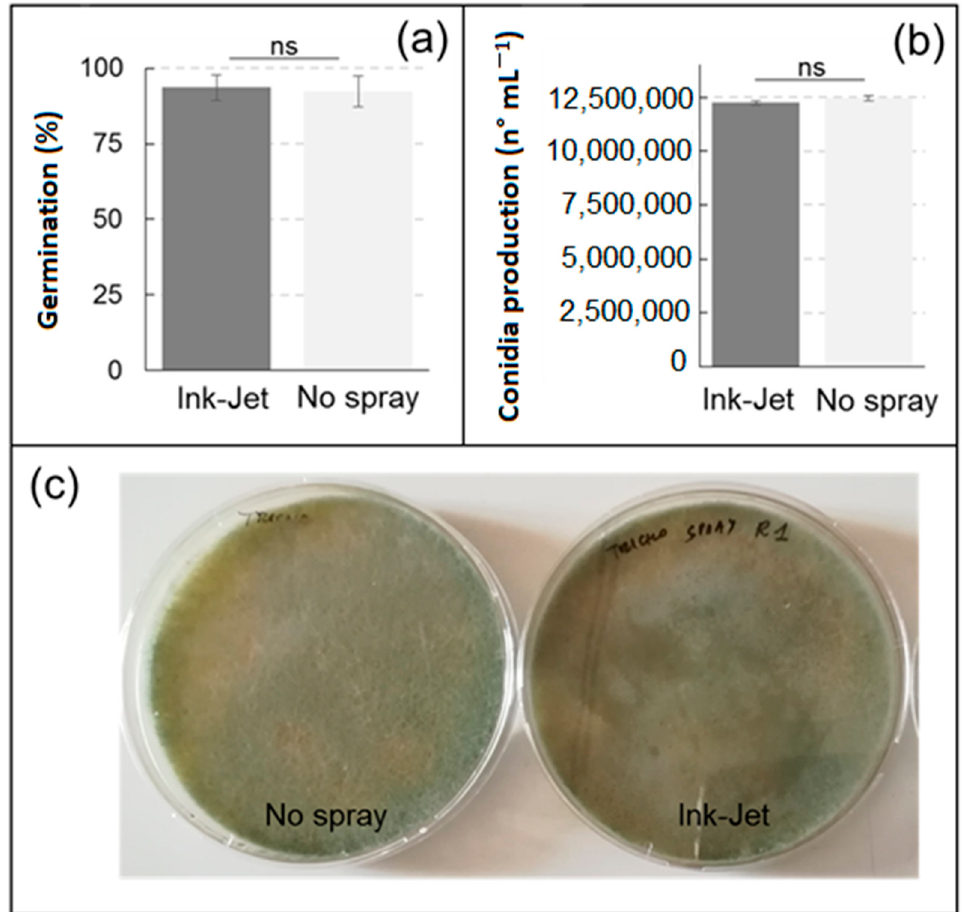
Figure 3. Spore germination ( a ) and conidia production ( b ) of Trichoderma harzianum after treatment with the ink-jet spray system. Data are means ± standard deviation, ns = statistically insignificant difference (Duncan’s test). ( c ) images of Trichoderma harzianum cultures on PDA obtained after seven days of incubation with control spores ( left ) or applied following treatment with ink-jet system ( right ). Germination of C. minitans spores was slightly lower than that of T. harzianum , but still high, being more than 90%. The percentage of germination was not statistically different between the control and the treatment with the ink-jet spray system (Figure 4). Conidia production of C. minitans was comparable between the two treatments after 21 days of incubation, with no statistically significant differences (Figure